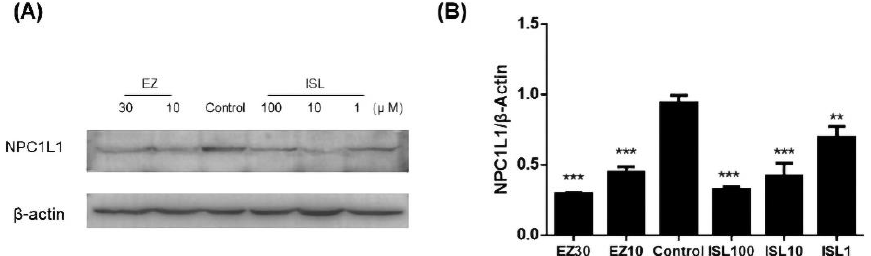
Figure 8. Effect of ISL on NPC1L1 protein expression in HepG2 cells. ( A ) Cells were treated with different concentrations of ISL for 24 h, and whole cell lysates were analyzed by protein blotting. ( B ) Analysis of the optical densitometry of the protein blots. ** p < 0.001, *** p < 0.0001.